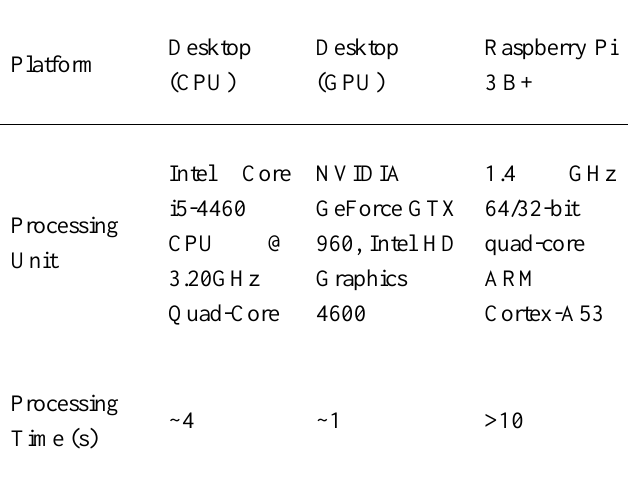
Technical specifications of different platforms for detection and